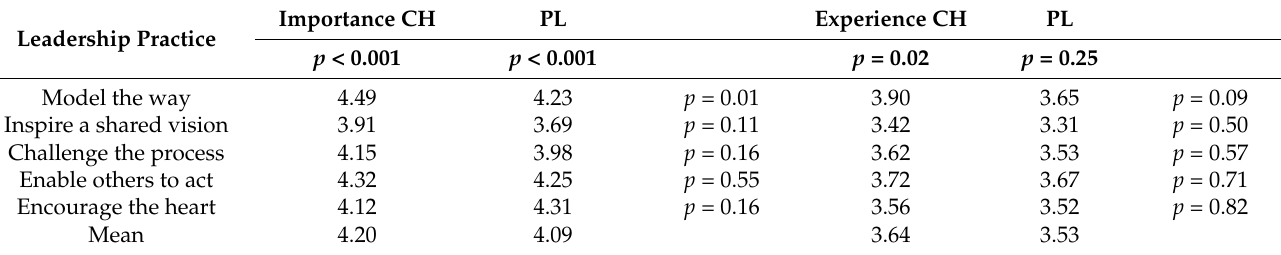
Table 5. Importance and experience for leadership practices by country.